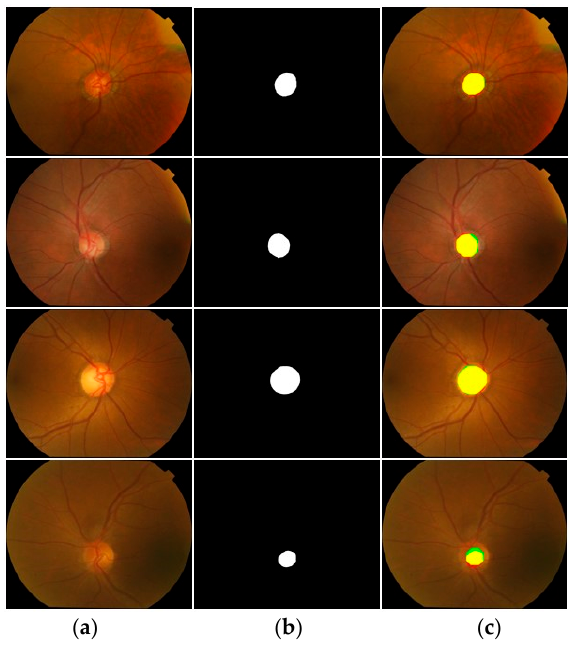
Figure 9. Good OC segmentation qualitative results on the Drishti-GS database, attained by applying FEDS-Net. ( a ) Input image, ( b ) corresponding groundtruth image, and ( c ) segmented output images (tp and fn pixels for OD are indicated in yellow and red, respectively, whereas fp pixels are presented in green color) (Rows 1–3: good segmentation results; Row 4: poor segmentation result).